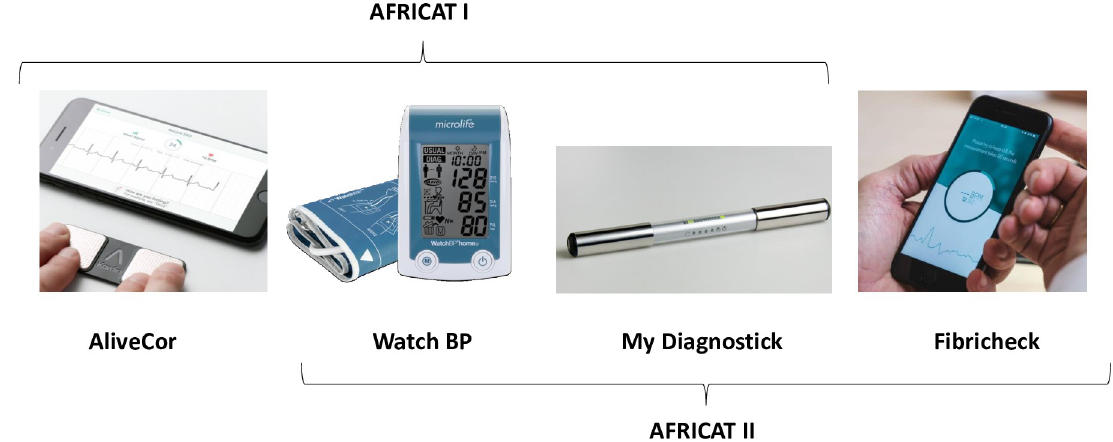
Fig 2. Devices used for AF